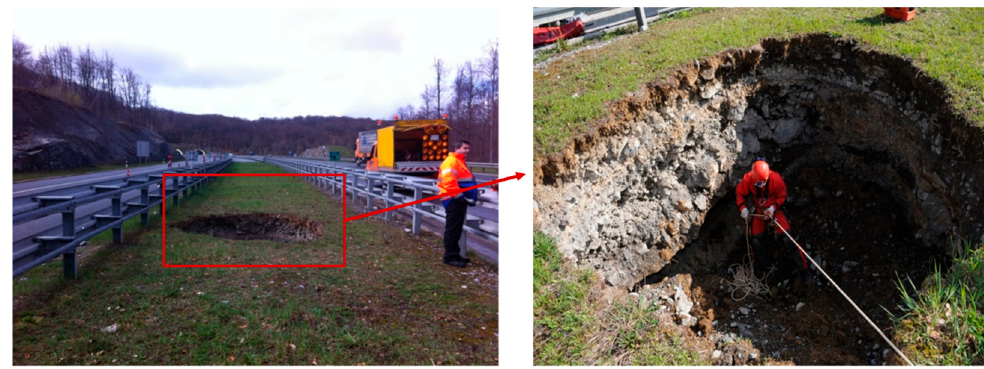
Figure 2. A sinkhole between the Rijeka–Zagreb highway lanes.